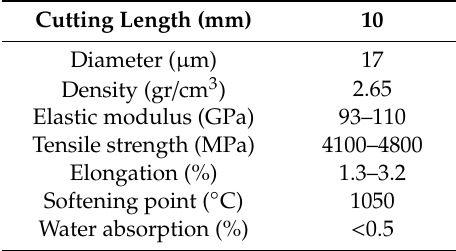
Table 3. Properties of basalt fiber (BF) used in the mortar specimens.